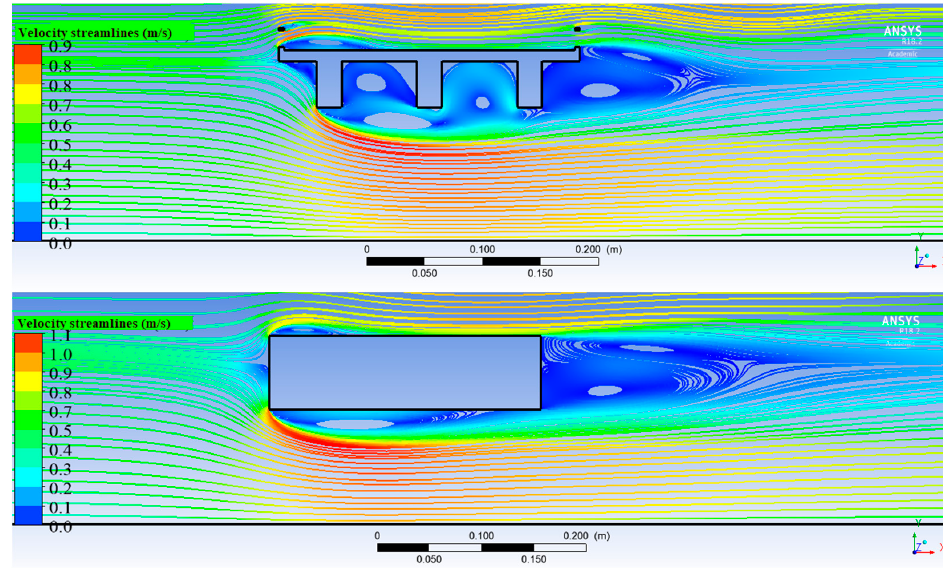
Figure 31. Streamlines of mean velocities around the box deck and three girder deck, Fr = 0.32, Pr = 1.5, h* = 2.